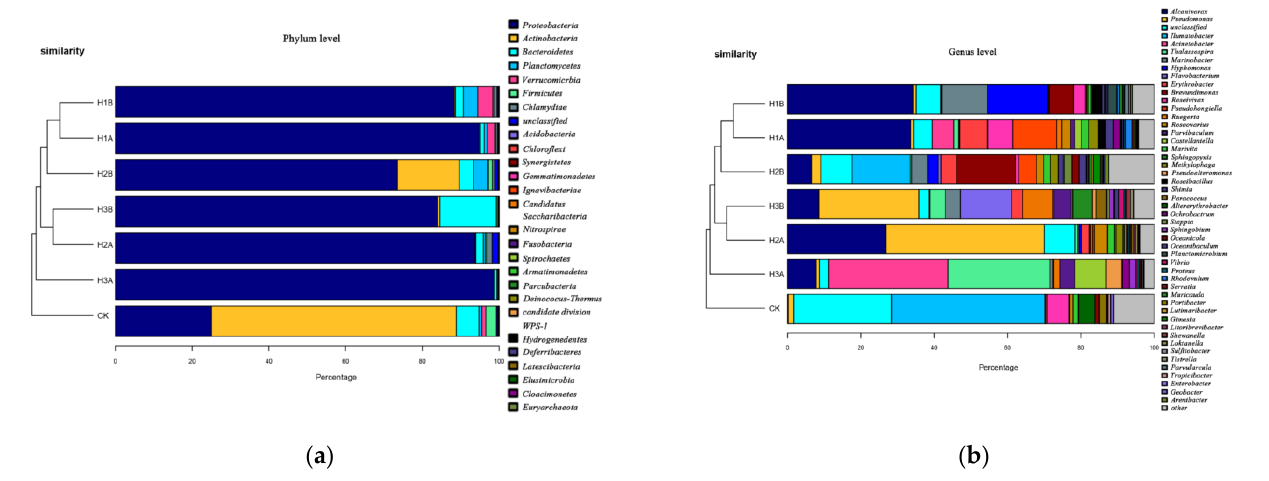
Figure 5. Effects of C. vulgaris LH-1 supplementation on bacterial community in seawater containing 10.00 g/L crude oil and different nutrient concentrations. ( a ) Phylum Level. ( b ) Genus Level. Table 3. Bacteria affected by C. vulgaris LH-1 at low crude oil